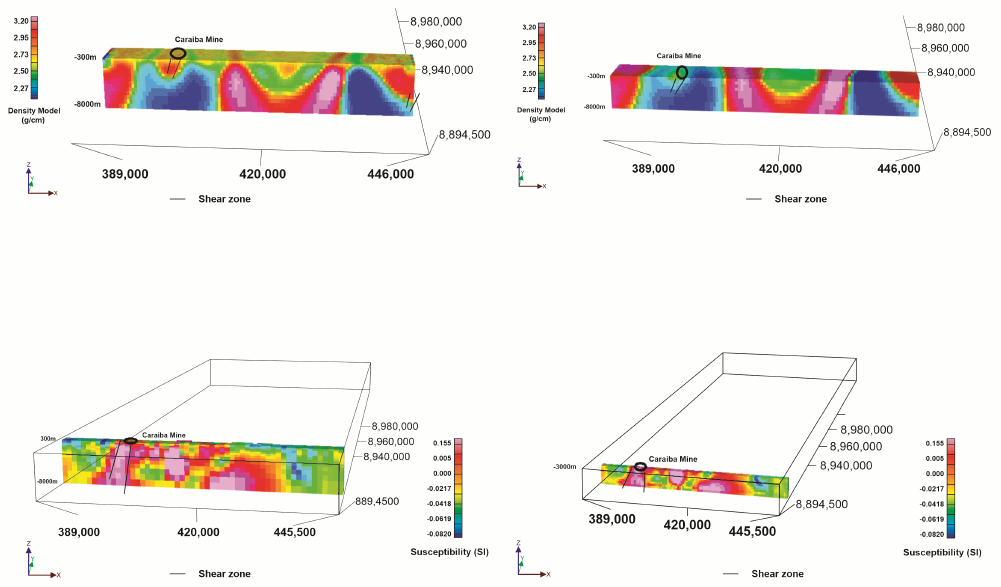
Figure 11. Density and magnetic susceptibility EW profiles in the southern portion of the Valley of the Curaça District, positioned between 300 m and 3000 m depth. Cara í ba mine is located in the eastern portion of the area with high density and magnetization values up to 3000 m depth.